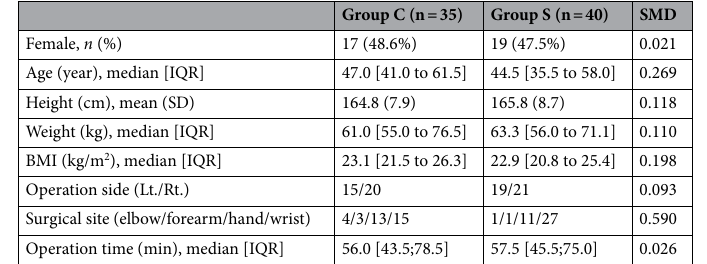
Table 1. Demographic and clinical characteristics. BMI body mass index, SMD standardized mean